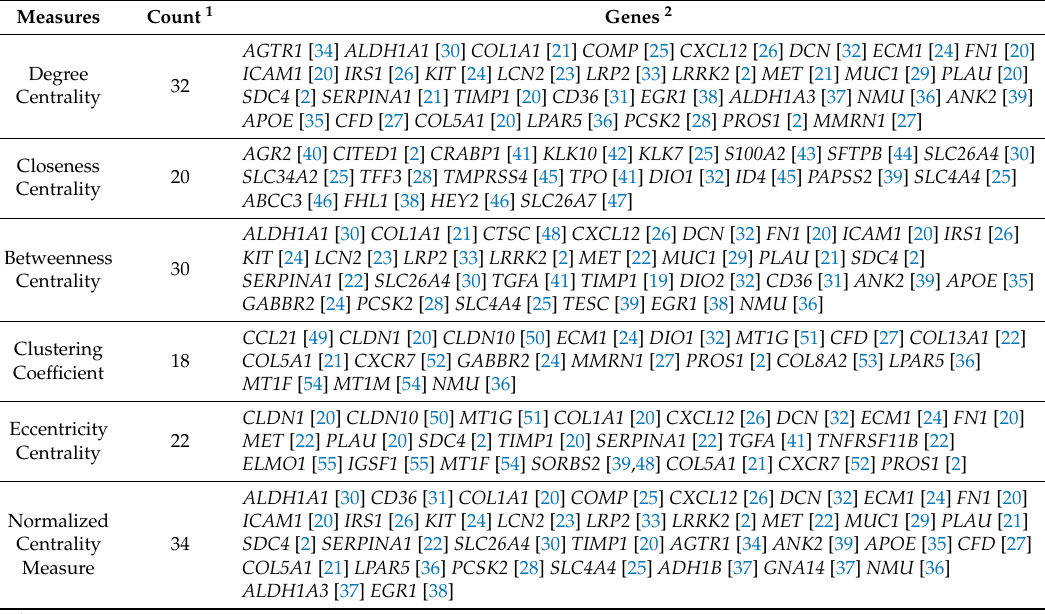
Table 2. References of PTC-related genes in top 40 captured